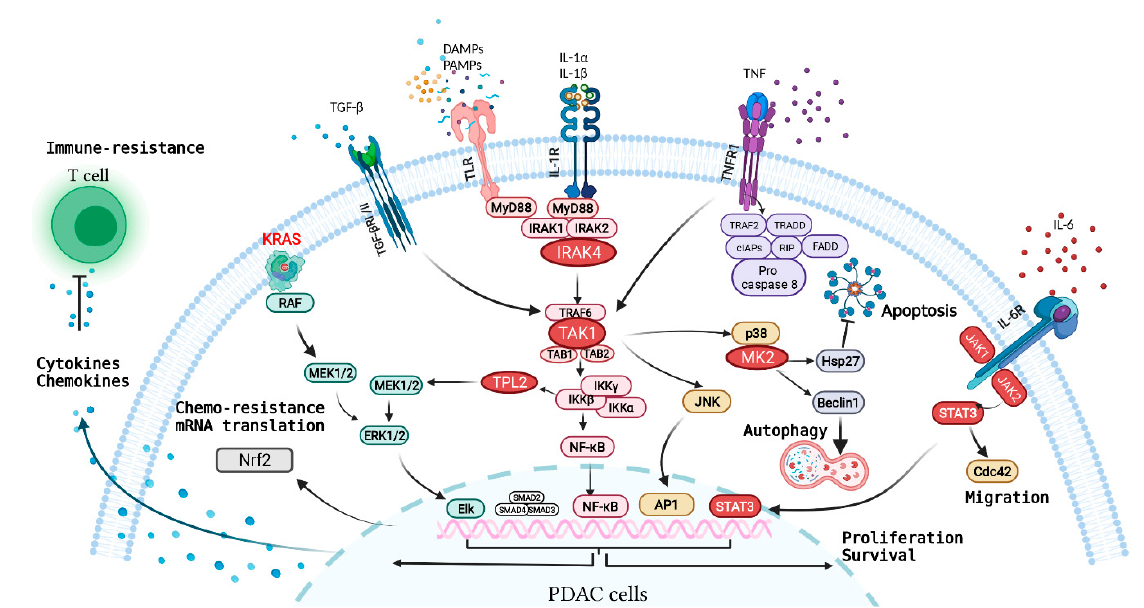
Figure 2. Overview of major inflammatory receptors and the associated signaling network in PDAC cells. Oncogenic KRAS in transformed PDAC cells drives secretion of inflammatory cytokines/chemokines such as IL-1 α / β , IL-6, and CXCL1 that subvert other cell types in the TME, causing production of more cytokines and chemokines in the TME. These secreted factors engage with inflammatory receptors on PDAC cells, driving a network of signaling pathways that synergize with oncogenic KRAS signaling in propelling various malignant feats of PDAC.